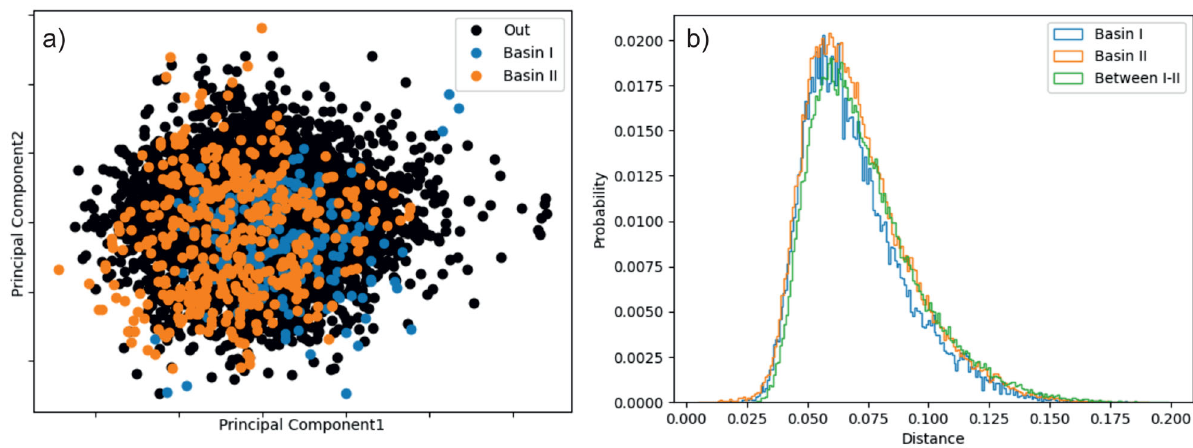
Fig. 9 PCA of the nicotinamide:benzoic acid co-crystal predicted structures. a The fi rst two principle components of the SOAP kernel for structures for co-crystal GAZCES in space group P 2 1 / c , coloured according to the basin identi fi ed from threshold simulations. Structures labelled in black fall outside of the two main basins (see Fig. 4c). b Distribution of pairwise dissimilarities by the SOAP REMatch kernel between and within energy basins I and II